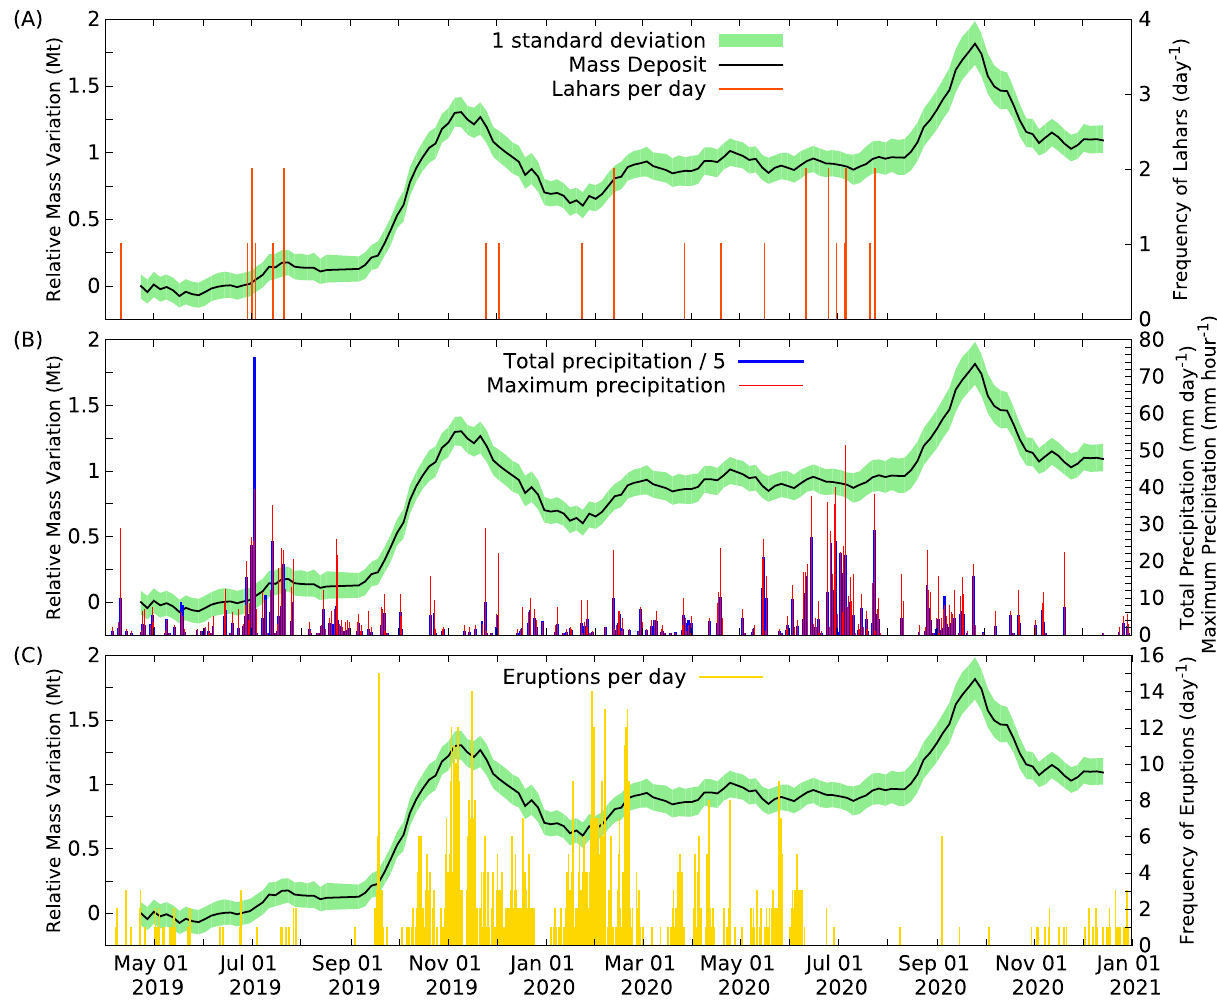
Figure 6. The relative variation of total mass measured through the three volcano regions is shown relative to the total mass measured during the 1st time-interval from 12th March to 21st April, 2019 as a function of time. The relative mass values (black lines) are plotted with 1 standard deviation error (green-coloured bands) and its variation is compared to the variations of the daily number of lahar events (orange-coloured impulses in A ), total daily precipitation (blue-coloured impulses in B ), maximum hourly precipitation (red-coloured impulses in B ) and daily number of eruptions (yellow-coloured impulses in C ),